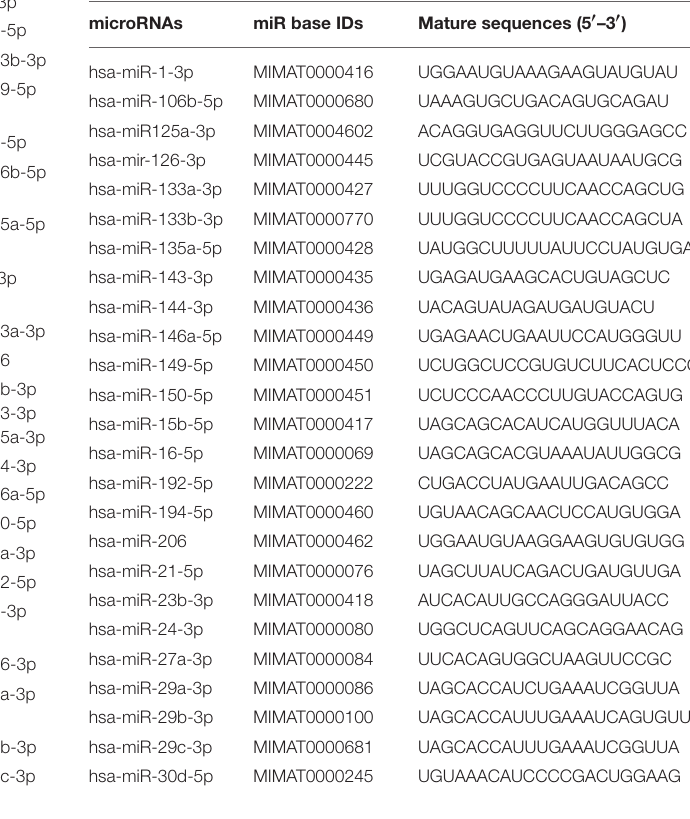
TABLE 2 | Final list of all miRNA candidates included in the present study, based on a comprehensive PubMed-based literature